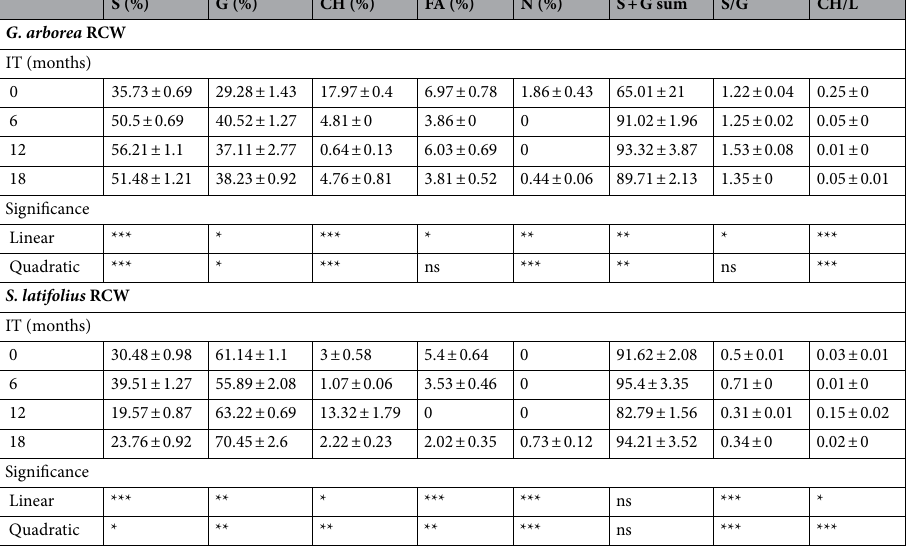
four lignins of G. arborea and S. latifolius , respectively. The identified products and their relative abundances are listed in Table S1 (Supporting data). Based upon the figure and Table 4, the distribution of the pyrolytic products from the lignins showed linear and quadratic variation in their chemical structure as the RCW degradation pro- gressed in soils. The main S-unit moieties that were present in the lignins were identified as peaks 15L, 16L, 18L, 22L, 25L, 26L, 30L, 37L (L refers to lignin). While the G-unit moieties were identified as 7L, 10L, 11L, 17L, 19L,